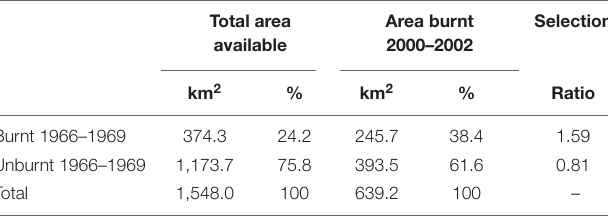
TABLE 2 | Comparison of two periods experiencing very large wildfires in the study area (1966–1969 and 2000–2002) showing areas (and percentage) of total sandplain shrubland burnt and unburnt in 1966–1969 and the area (and percentage) of these burnt in later fires of